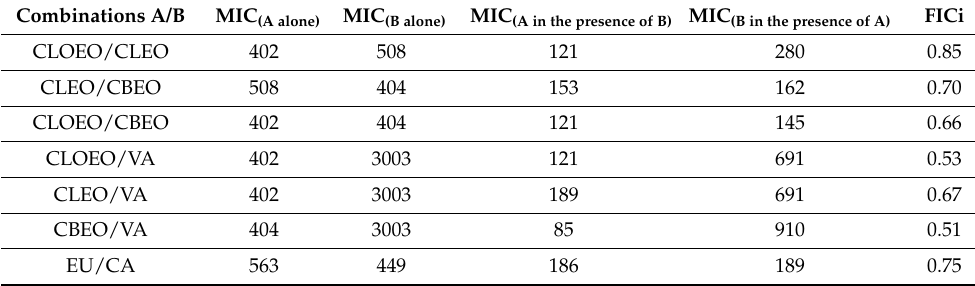
Table 2. FIC index (FICi) and interaction of selected binary combinations of antimicrobial compounds against L. monocytogenes. MIC values are expressed in